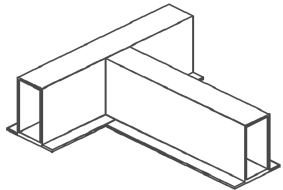
Figure 17. Constructing a grillage from rectangular pipes with flat bars attached to the bottom face.